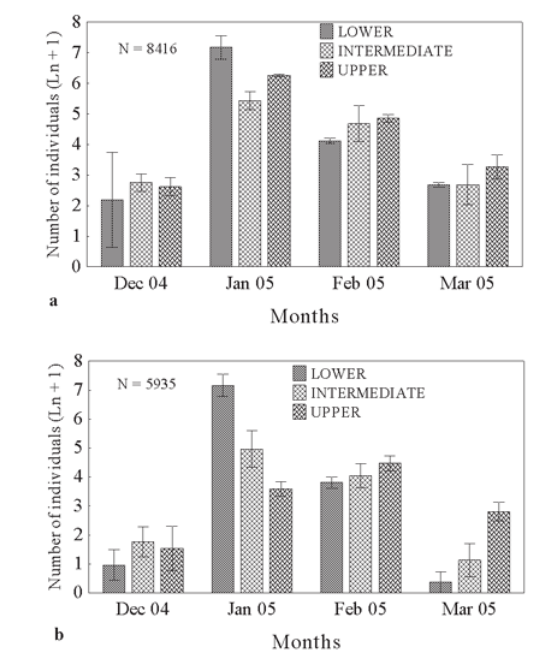
Fig. 4. Monthly averages of the total number of individuals (± standard error) (a) and of migratory species (b), captured at intervals of 8h in the different pools sampled in the fish ladder located at Engenheiro Sergio Motta Dam (N: total num- ber of